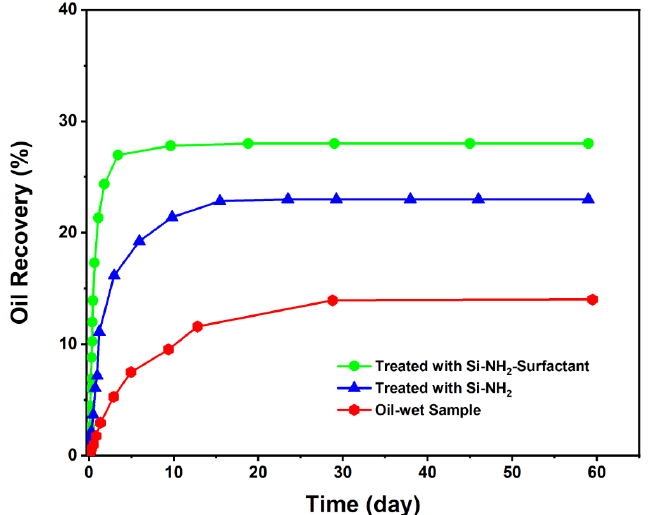
Figure 10. Spontaneous imbibition oil recoveries of the oil-wet sample, and core plugs treated with Si-NH 2 -surfactant and Si-NH 2